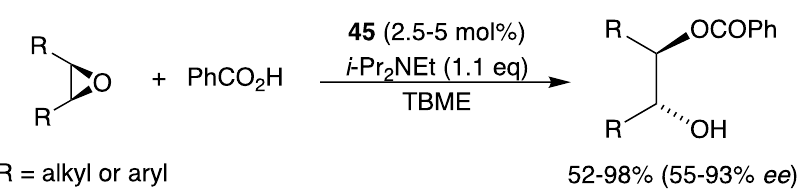
Figure 20. Co(II)salen complex 45 .